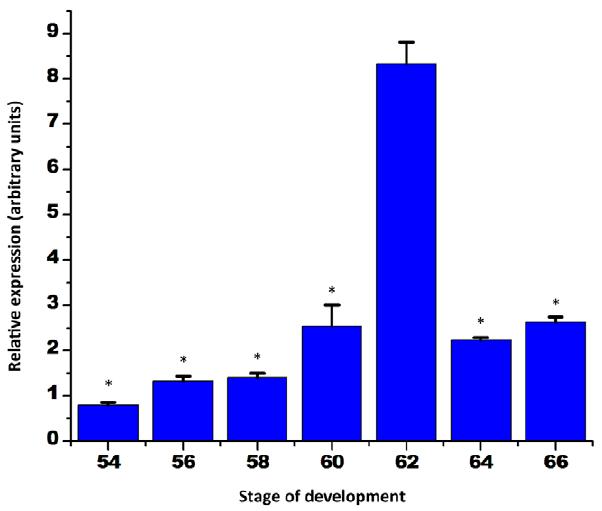
Figure 4. MDS/EVI is strongly upregulated in the intestine at the climax of metamorphosis. A primer set common to EVI and MDS/EVI was used for qPCR analysis on total intestinal RNA at different stages during metamorphosis as in Fig. 2. Note that the data is consistent with that in Fig. 2 if one considers the fact that there is little non-Ep in premetamorphic tadpoles at stage 56 but non-Ep increases as a percentage of the total intestine during metamorphosis. Error bars indicate SEM (n=3). * indicates transcript levels lower than the peak expression (p # 0.05).